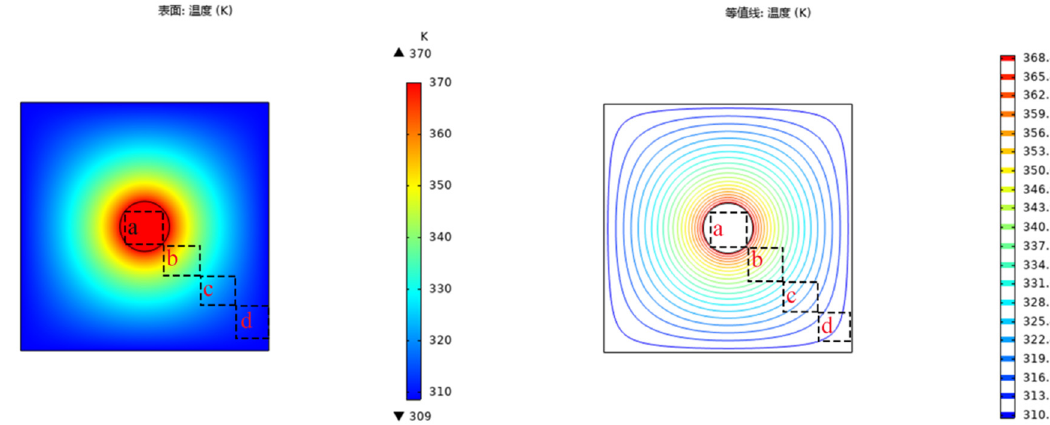
Figure 7: Schematic of software simulation of the thermal transfer from the center to the edge on the same plane.